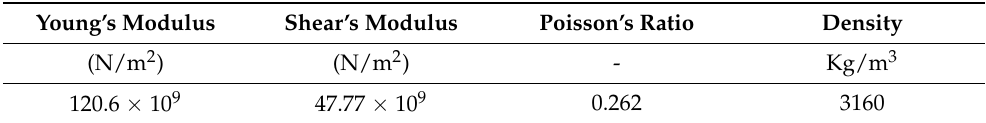
Table 3. Material properties of the tympanosclerosis plaques [13,14,24]. Young’s